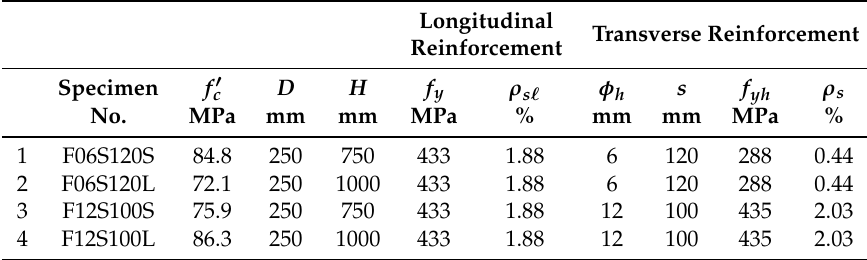
Table 1. Details of reinforced concrete